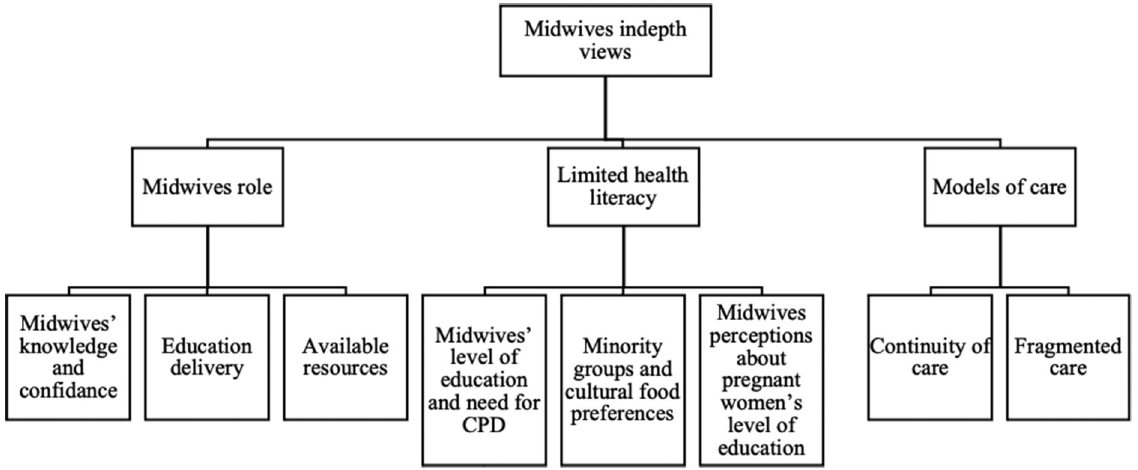
Figure 1. Midwives views after attending healthy eating education